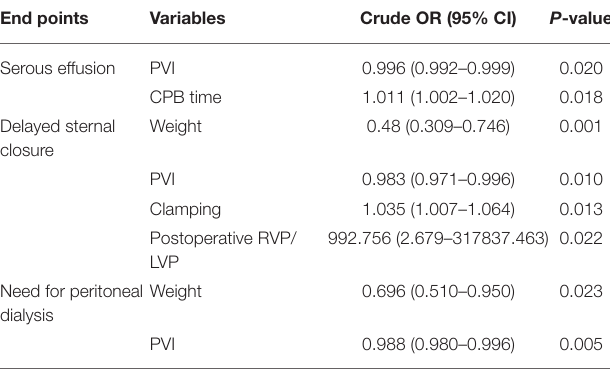
TABLE 6 | Multivariate analysis of Risk factors for major postoperative